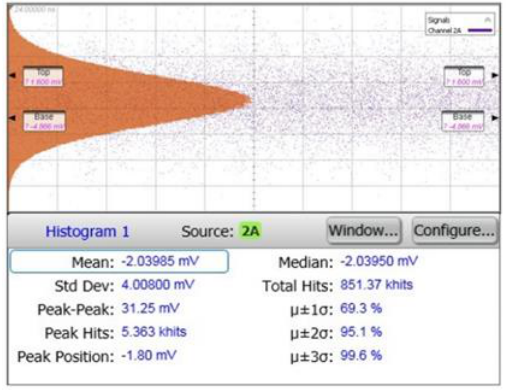
Figure 11. Measured noise output voltage of the proposed Rx IC.